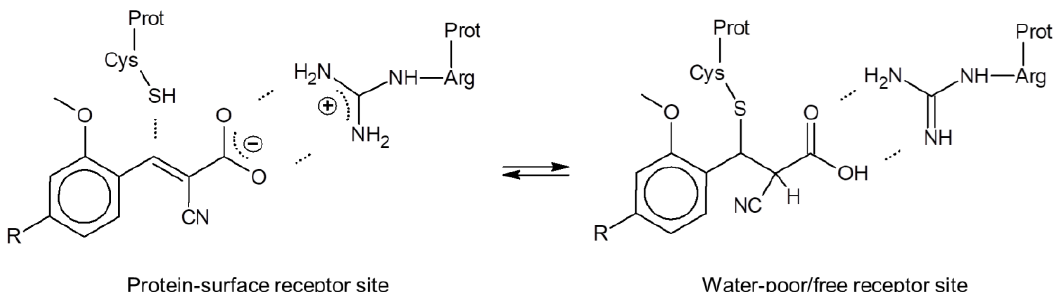
Figure 2. Hypothetical MCT-inhibitor binding at the extracellular surface (left) and at an interior protein site with no aqueous solvation (right). Michael addition may become active for the neutral carboxylic acid form (right), but would be reversible due to the α -CN substitution that enhances the retro-Michael reaction significantly (see, e.g., [34,35]).